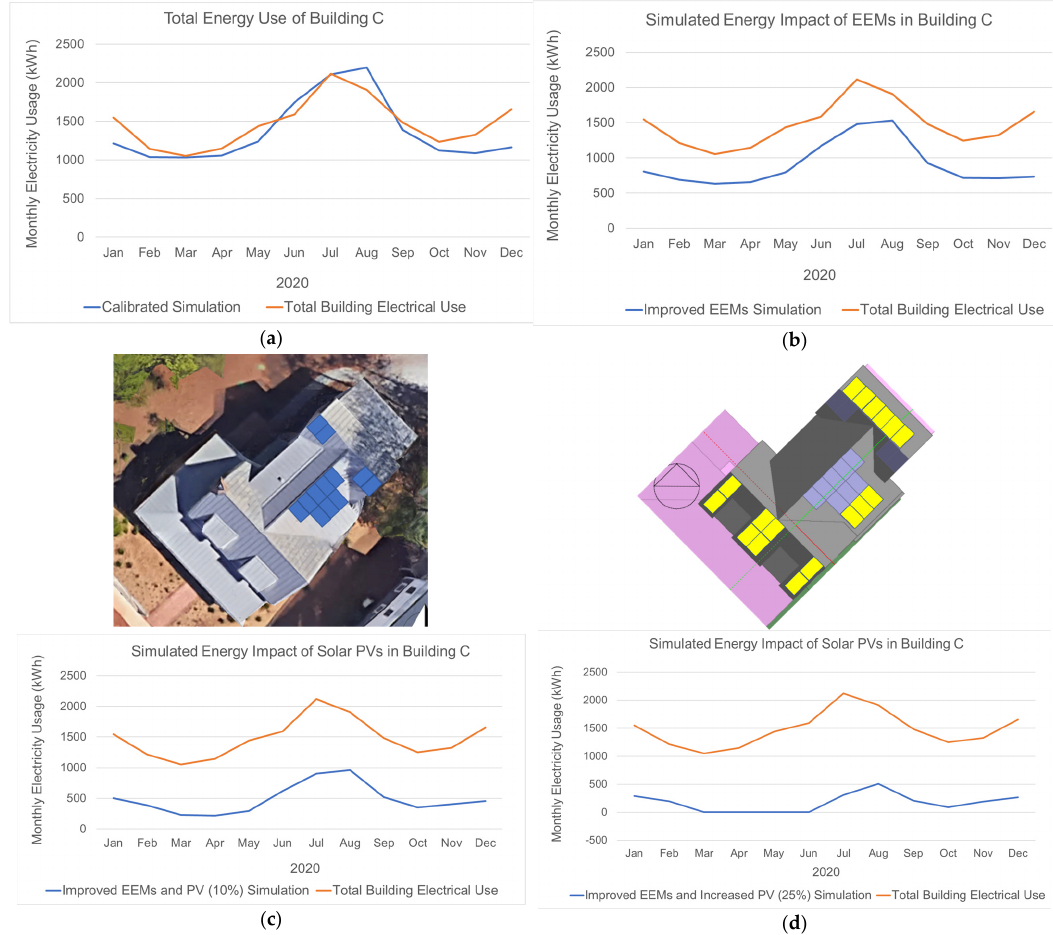
Figure 9. Systematic analysis to verify net zero in building C. ( a ) Calibrated base case vs. measured baseline. ( b ) Energy use reductions from improved EEM simulation vs. measured baseline. ( c ) Utility energy use reductions with improved EEMs and PV (10%) simulation vs. measured baseline. ( d ) Utility energy use reductions with improved EEMs and PV (25%) simulation vs. measured baseline.